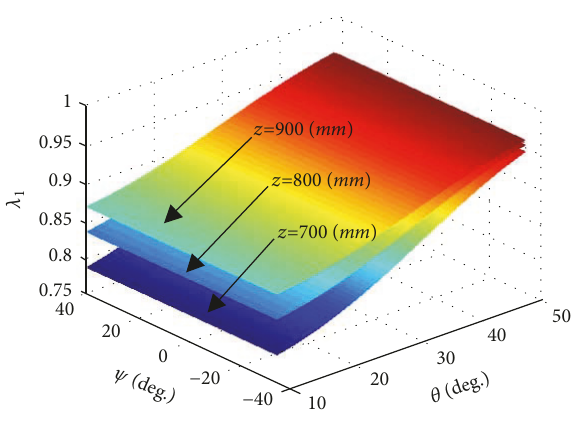
Figure 13: Output efficiency coefficient of the limb RPU.